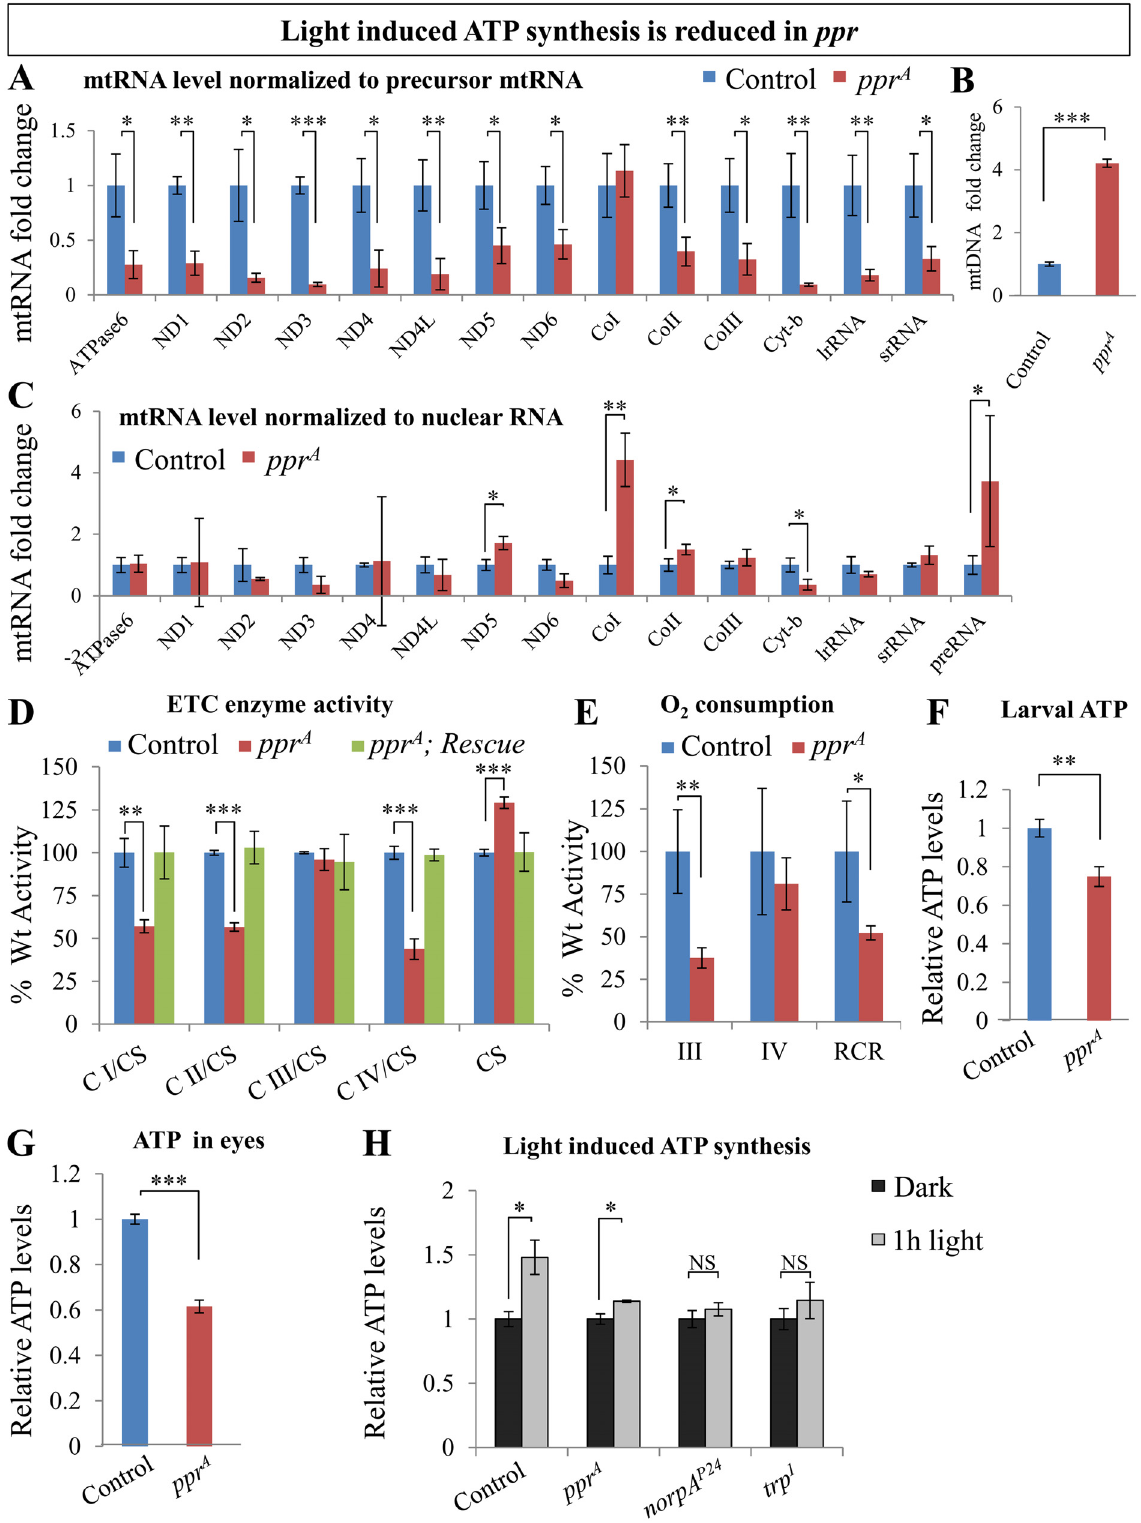
Fig 6. Light-induced ATP synthesis is reduced in ppr mutant eyes. (A) Relative mtRNA levels, normalized to precursor RNA transcribed from the heavy strand (+) of the mitochondrial genome, in control and ppr A third instar larvae. (B) Relative mtDNA content, normalized to nuclear DNA, in control and ppr